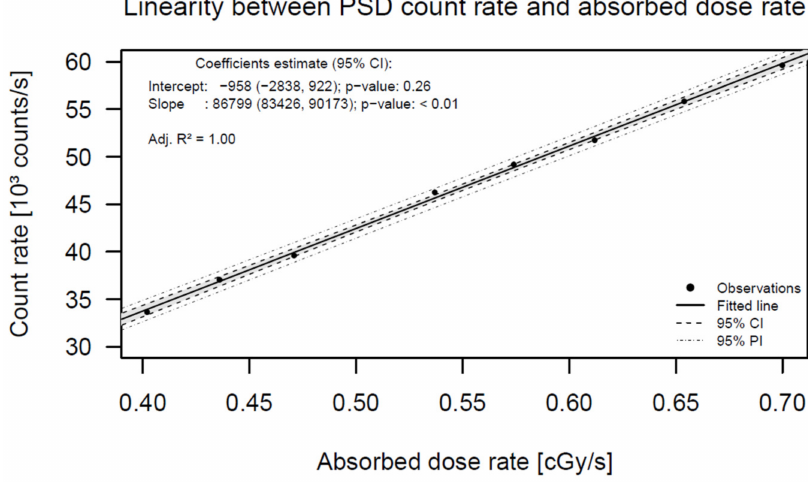
Figure 4. Linear regression of the PSD count rate with the absorbed dose rate.